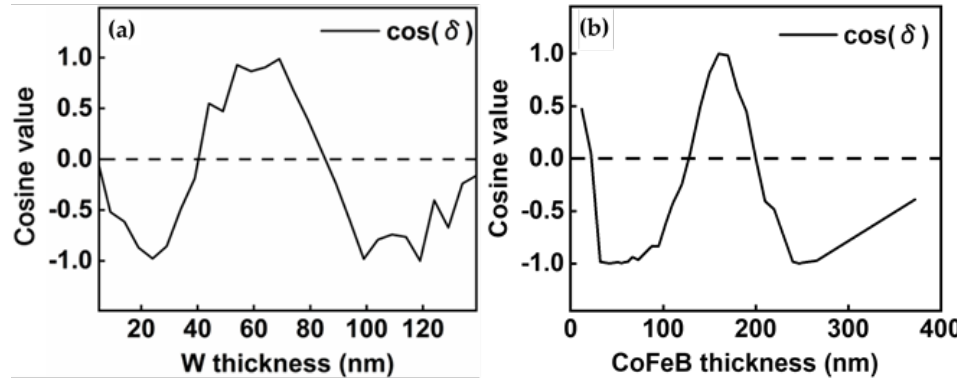
Figure 9. ( a ) The calculated cos ( δ ) for the W/CoFeB (120 nm)/W thin films with the W layer thickness changing from 4 to 140 nm; ( b ) the calculated cos ( δ ) for the CoFeB/AAO thin films with a CoFeB layer thickness from 12 to 372 nm.